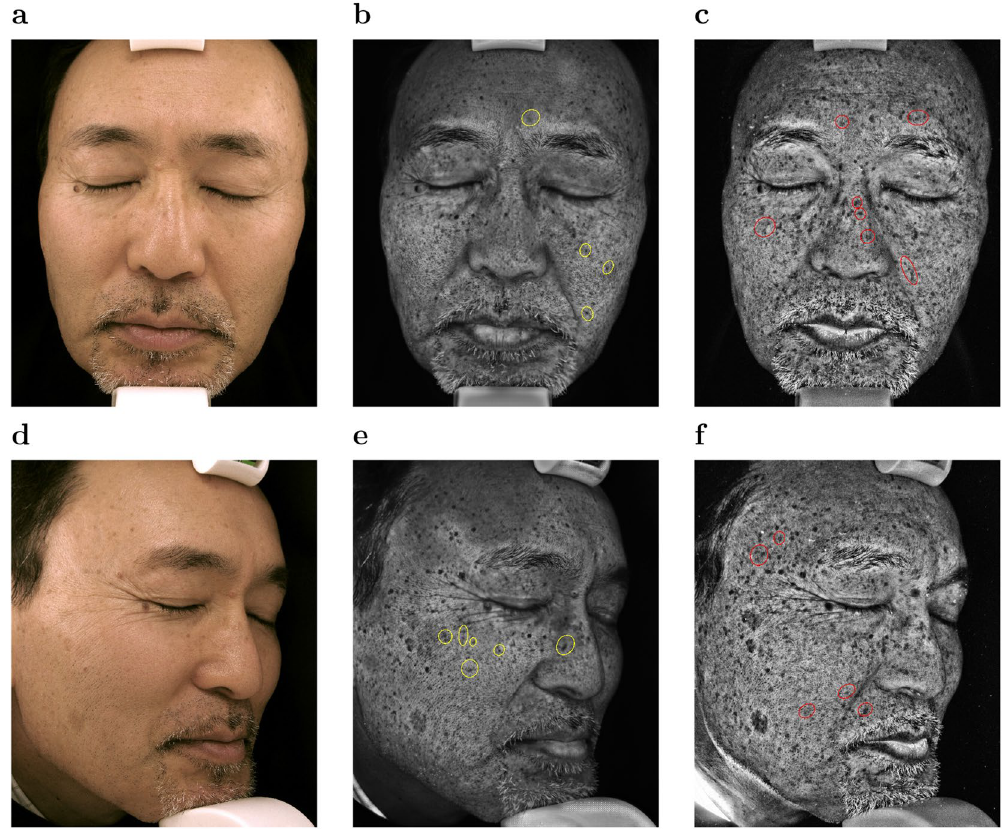
Figure 2. Color photo images of a front face and a right profile face ( a , d ), synthetic UV images generated by UV-photo Net ( b , e ), and UV photo images ( c , f ) for a